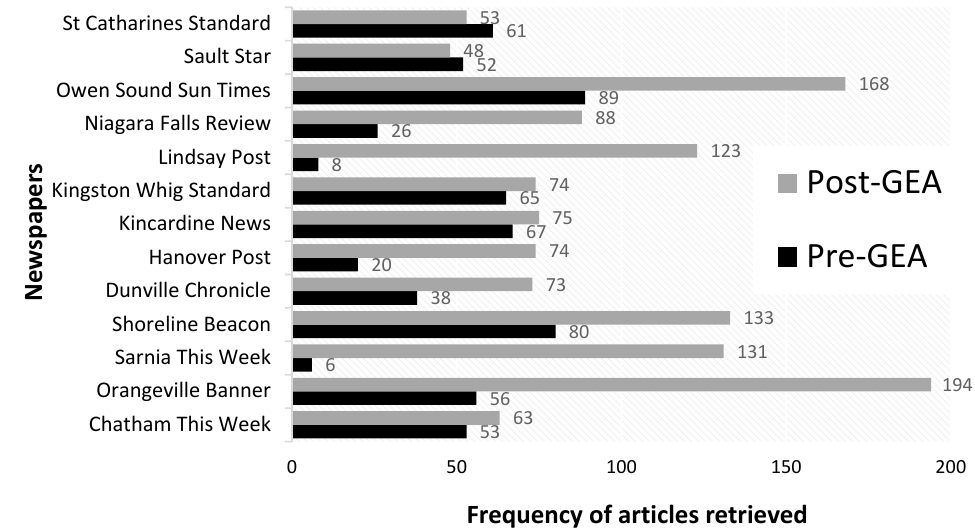
Figure 3. Frequency of sampled articles by newspaper source.